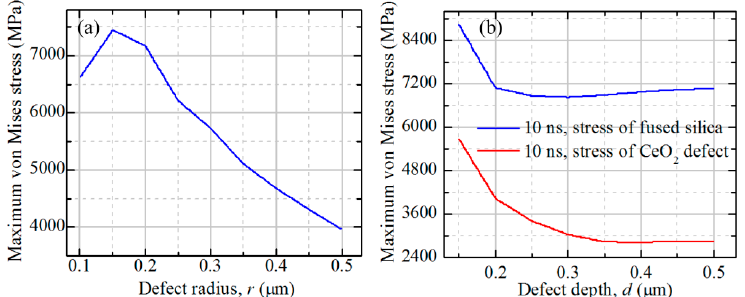
Figure 9. Evolution of the maximum von Mises stress caused by CeO 2 impurity defect with respect to the defect radius ( a ) and depth ( b ) when the fused silica surface is irradiated by incident lasers for 10 ns. The maximum thermal stresses in fused silica and CeO 2 defect are both presented in ( b ).